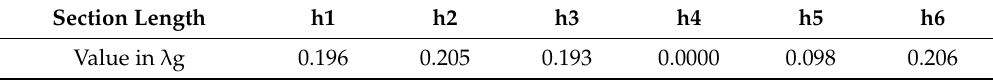
Table 1. Passive waveguides lengths of the optimized structure.